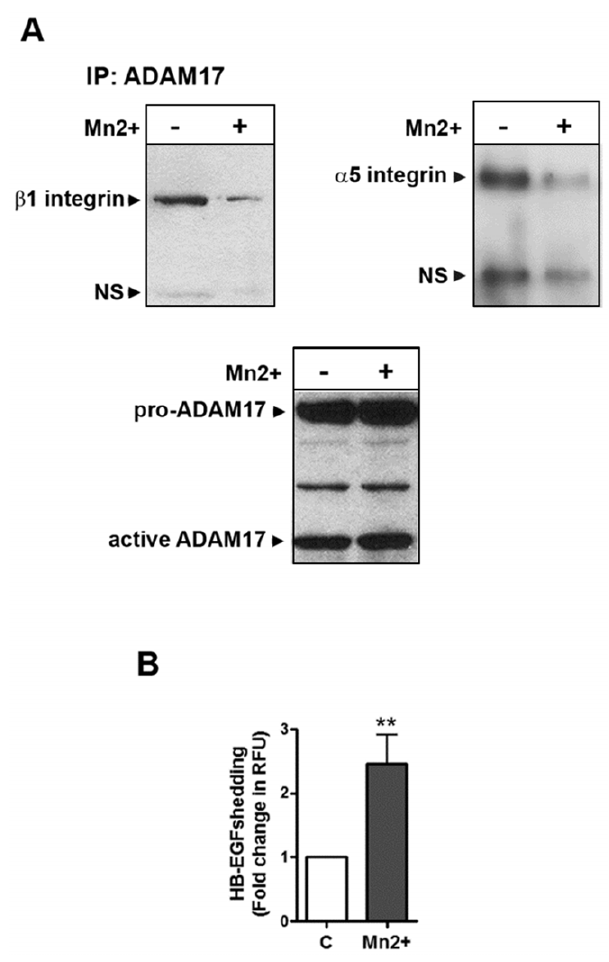
Figure 5. Manganase 2 + stimulation decreases association of ADAM17 to b 1 integrin and leads to increased ADAM17 activity. (A) Control and manganese stimulated (1 mM MnCl 2 in PIPES buffer for 2 min) mesangial cell lysates were immunoprecipitated with ADAM17 antibody. Samples were resolved on a 3–8% Tris-acetate gel and probed for b 1 integrin and a 5 integrin by Western blotting. Immunoblotting for ADAM17 served as loading control. Arrows point to specific and non-specific (NS) bands. One representative blot out of three is shown. (B) Mesangial cells were transfected with AP-HB-EGF construct and stimulated with 1 mM MnCl 2 in PIPES buffer. HB-EGF shedding was expressed as mean 6 S.D. of fold increase in the rate of change of relative fluorescence units (RFU); **p , 0.01 vs control; n=three experiments, 6 parallels/each condition.